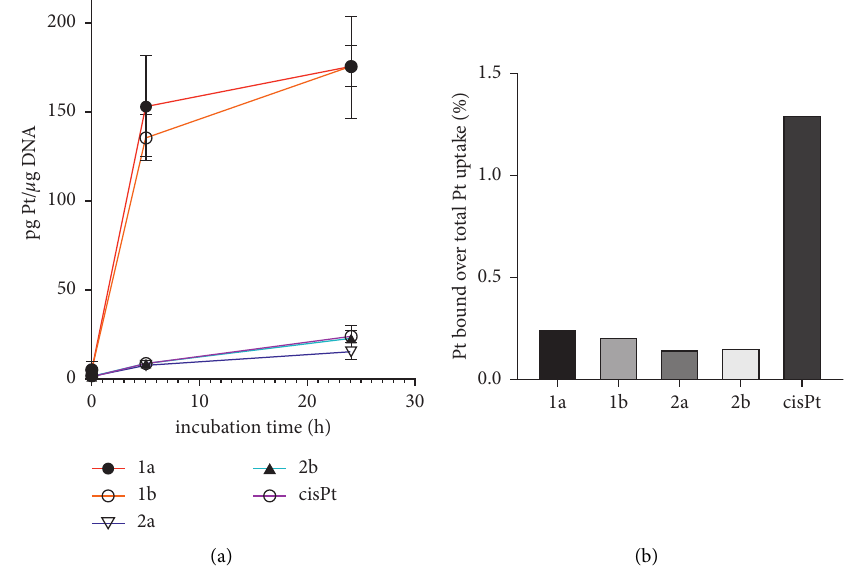
Figure 5: (a) DNA platination in MDA-MB-231cells treated for 5 and 24h at 10 µ M concentrations of Pt(II) complexes. All results are expressed as the mean ± SD from three independent experiments. (b) The percentage of Pt bound to DNA over the total Pt taken up to MDA-MB-231 cells (5h incubation). Table 2: IC 50 values ( μ M) and for Pt(II) alkylpyrazole complexes and cisplatin as determined in Chinese hamster ovary CHO-K1 cell line (wild-type) and its mutant cell line MMC-2 deficient in DNA nucleotide excision repair by MTT assay after 72h treatment.